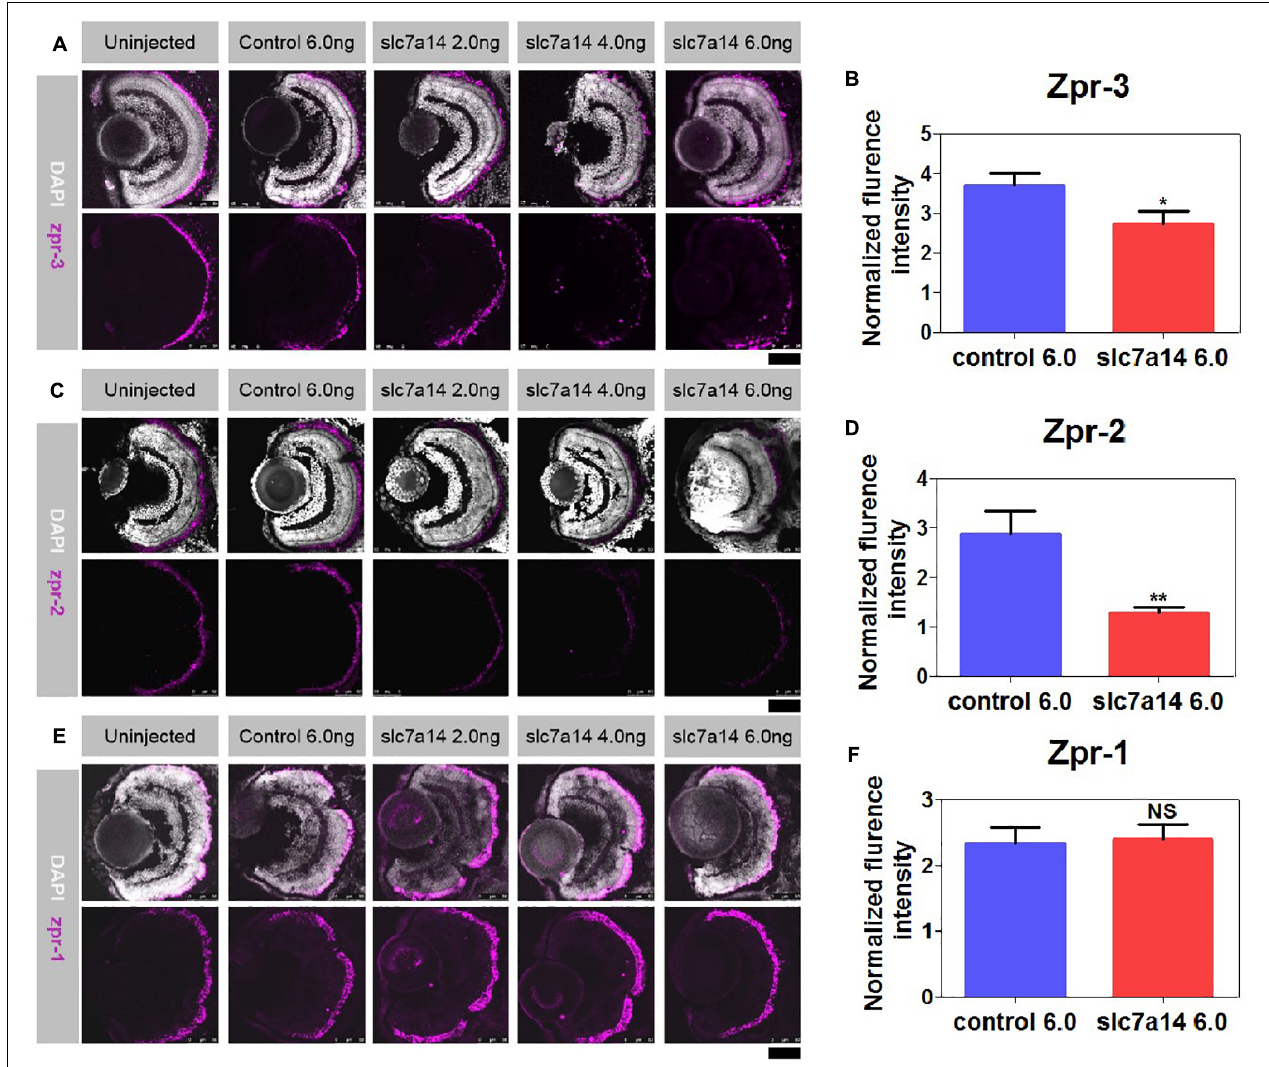
FIGURE 3 | Immunostaining of zpr-1, zpr-2, and zpr-3 in slc7a14 -deficient morphants. (A) In the peripheral retina, the high-dose slc7a14 -MOs led to sharp reductions in zpr-3. Weaker fluorescence signals were detected in the high-MO dose groups ( slc7a14 4.0 ng and slc7a14 6.0 ng) than in the control group. (B) Statistical results for zpr-3 ( n = 10 for each group). (C) The high-dose slc7a14 -MOs led to significant reductions in zpr-2. There were few fluorescence signals in the peripheral retina in the high-MO dose group ( slc7a14 6.0 ng). The RPE in the low-MO dose group ( slc7a14 2.0 ng) was relatively normal compared to that in the wild-type group and control group. (D) Statistical results for zpr-2 ( n = 10 for each group). (E) No significant changes were found in cone photoreceptors. (F) Statistical results for zpr-1 ( n = 5 for each group). Scale bar = 50 µ m. Bar plots were shown as the mean ± s.e.m. T -test was performed between the two groups. ∗ P < 0.05, ∗∗ P <